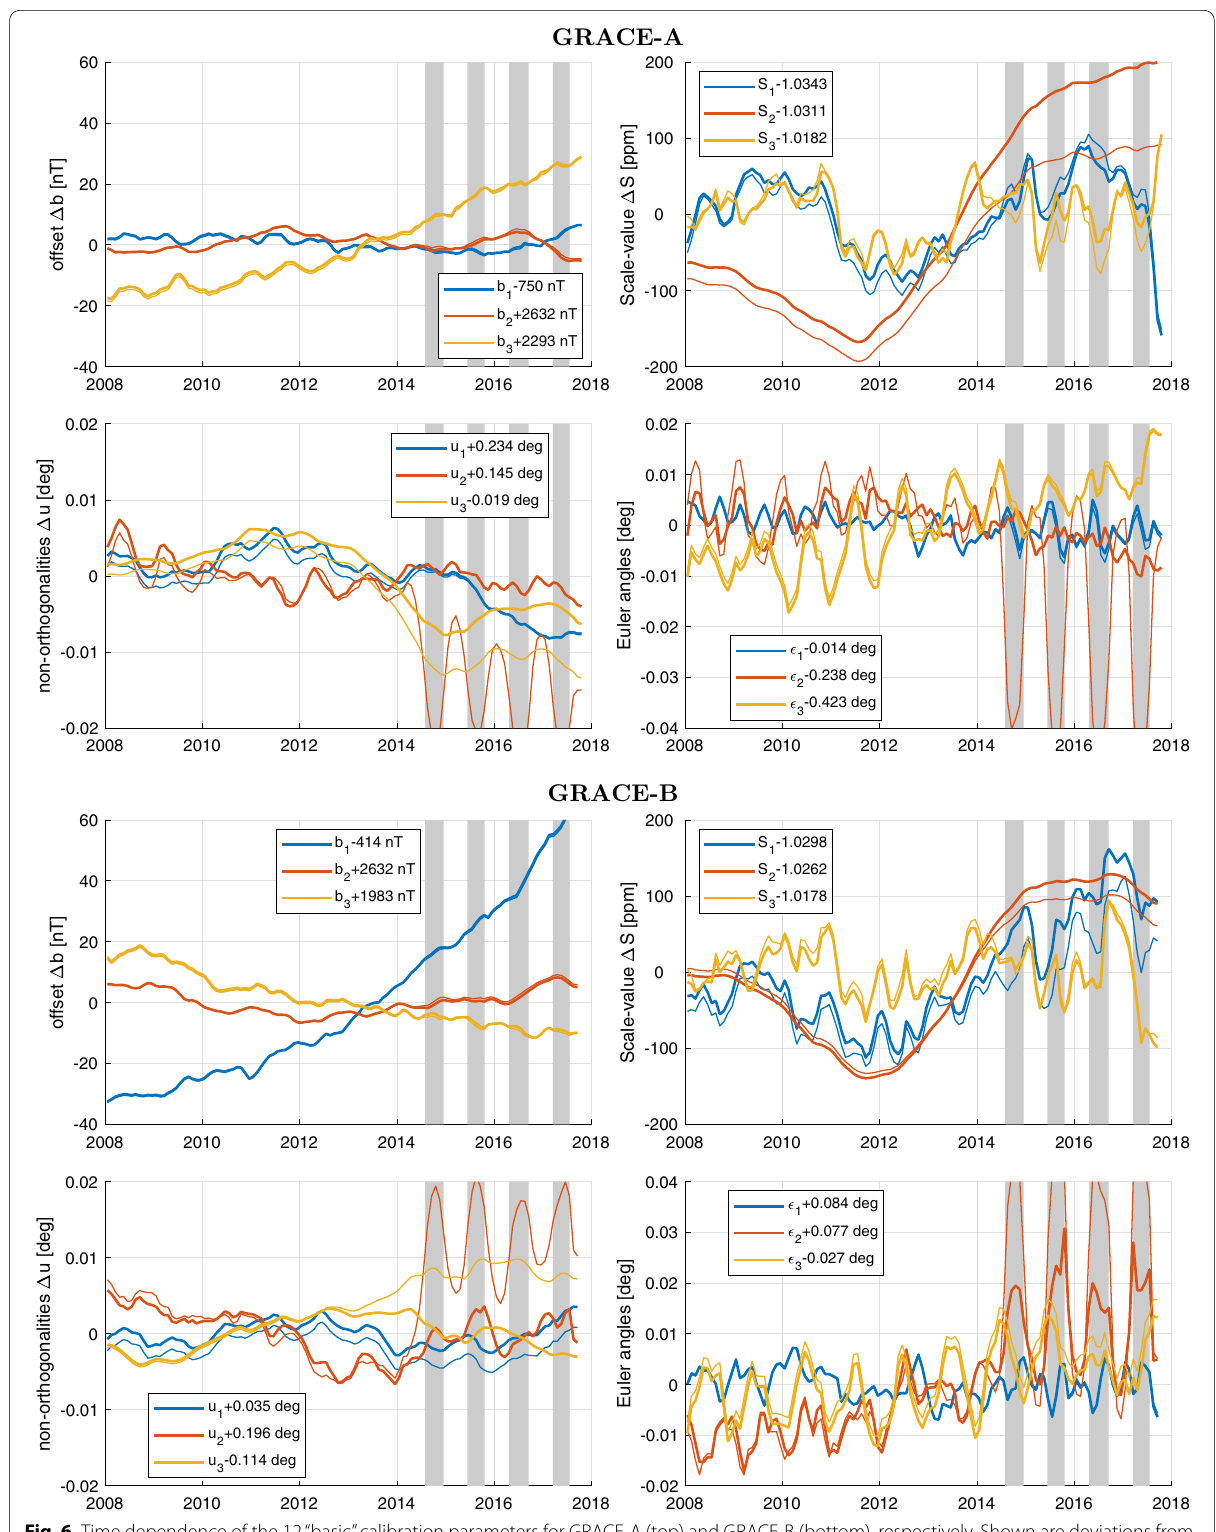
Fig. 6 Time dependence of the 12 “basic” calibration parameters for GRACE-A (top) and GRACE-B (bottom), respectively. Shown are deviations from their mean values as indicated in the figure legend. The thin curves present a calibration model that does not include the 12 correction parameters for “reverse flying satellite” periods shown in